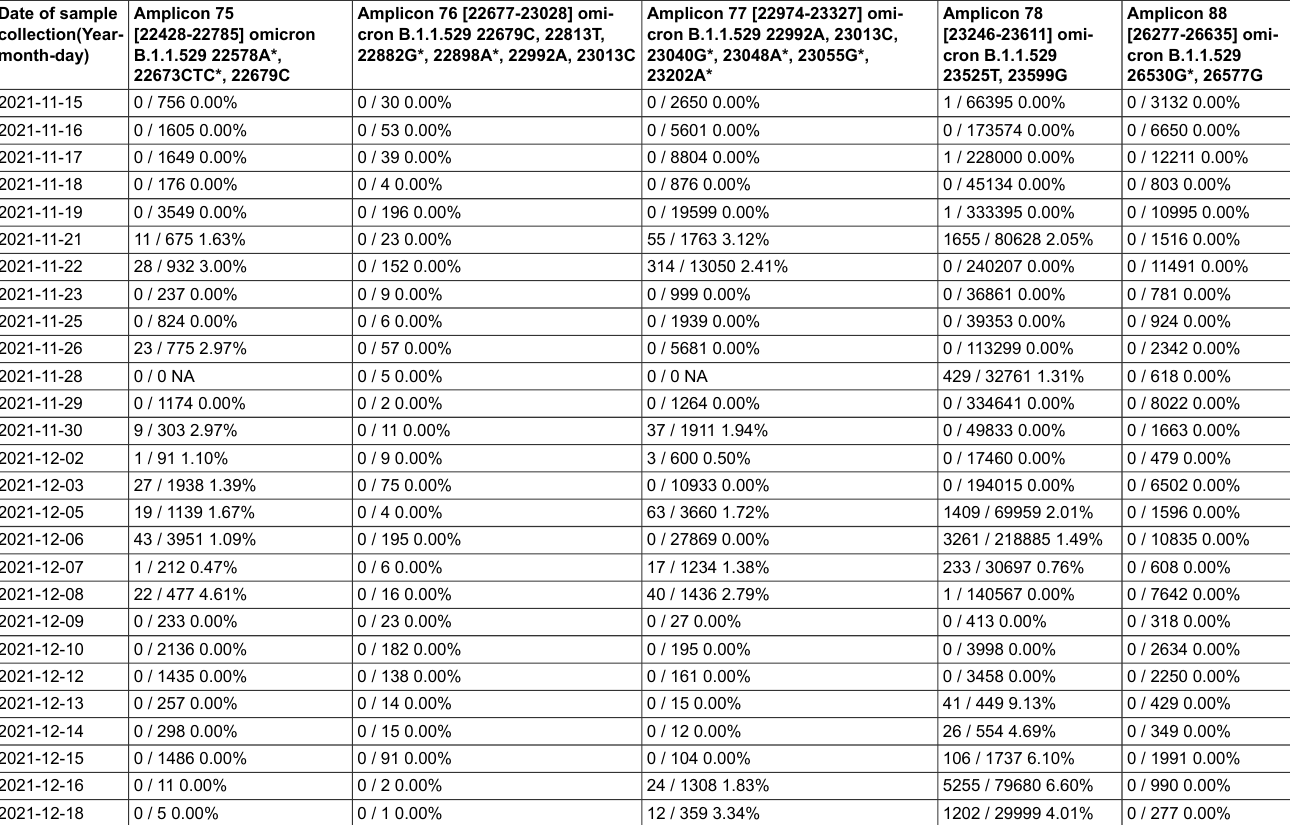
Table S1: Early detection of B.1.1.529 (Omicron) variants of SARS-CoV-2 in wastewater samples with amplicons